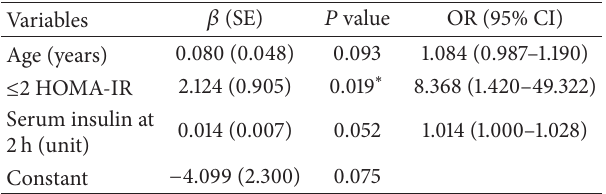
Table 7: Model for predicting abnormal sensory nerve function (Model